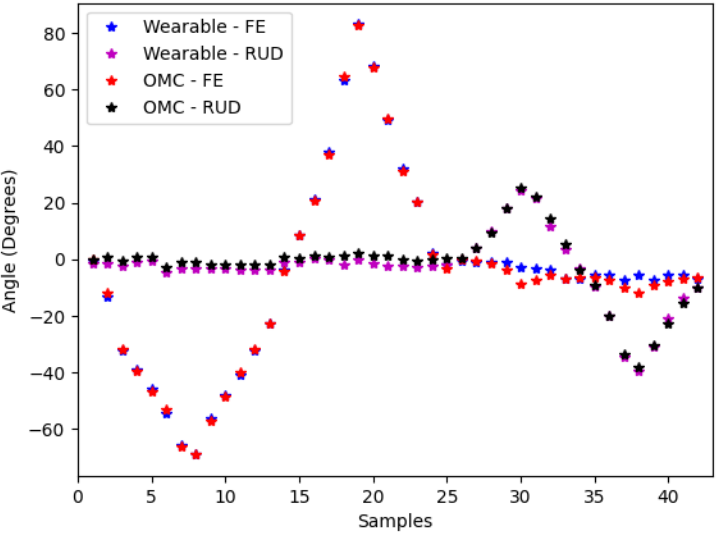
Figure 5. Wearable and optical motion capture (OMC) flexion/extension (FE) and radial/ulnar deviation (RUD) calibration trials, with calibration